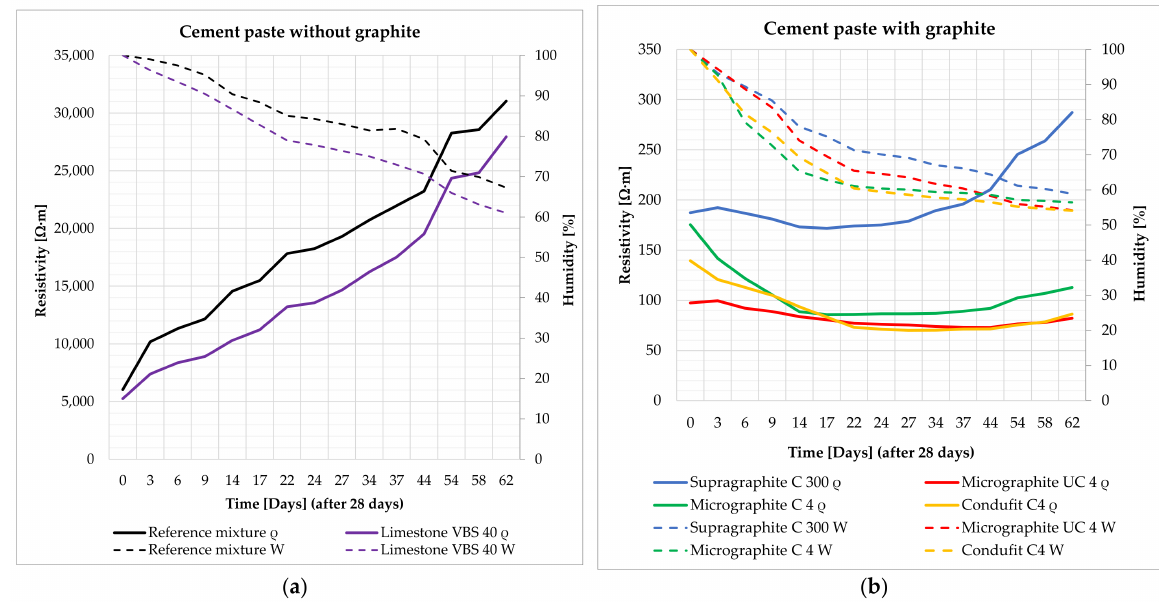
Figure 8. The effect of humidity on the resistivity of cement pastes: ( a ) without the graphite; ( b ) with the graphite.